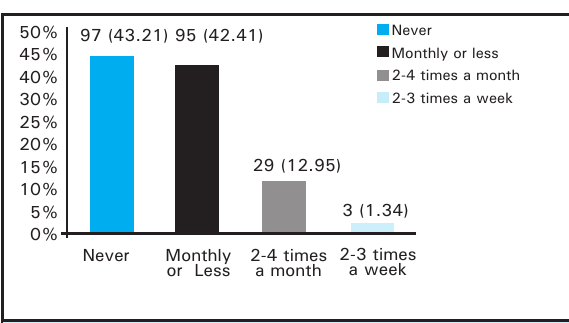
Figure 3. Frequency of Alcohol Consumption Among Dental